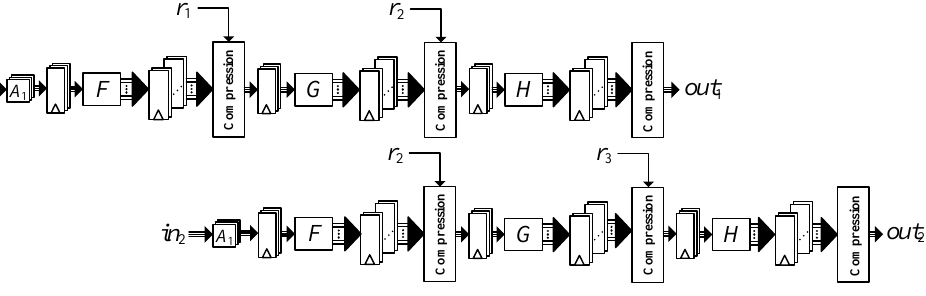
Figure 7: Emulation of fresh mask reuse in PRINCE